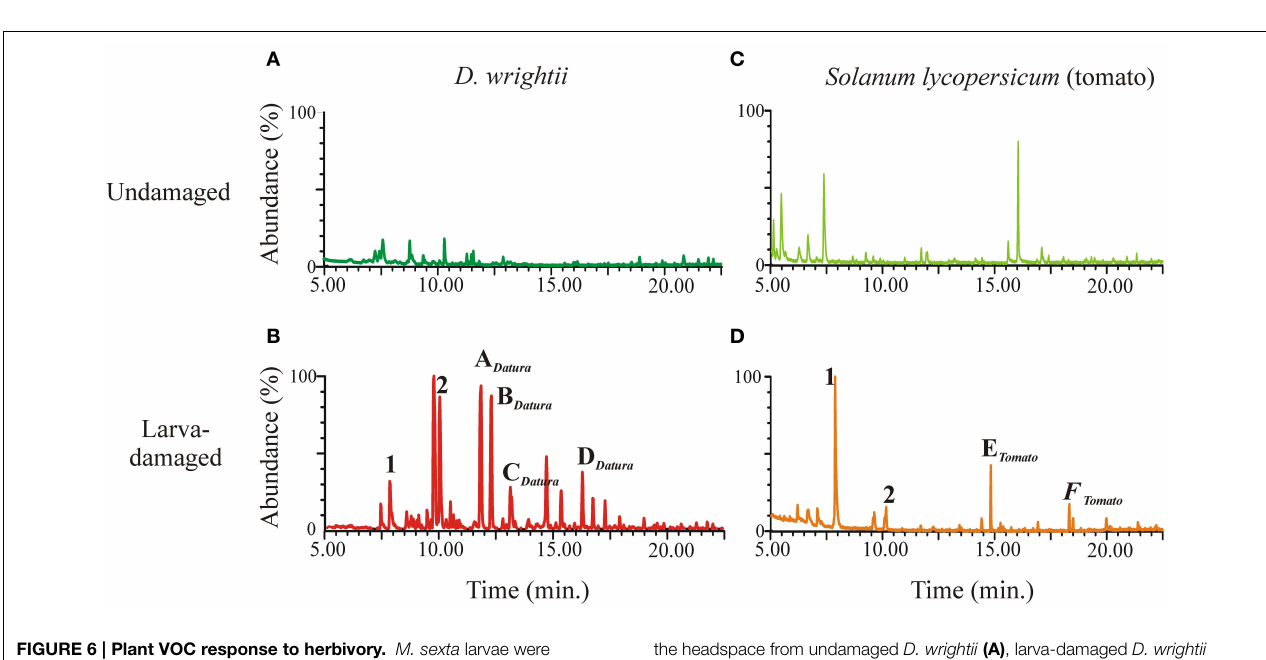
the headspace from undamaged D. wrightii (A) , larva-damaged D. wrightii (B) , undamaged tomato (C) , and larva-damaged tomato (D) . In (C,D) same numbers or letters, respectively indicate common and different compounds emitted by larva-damaged vegetation.